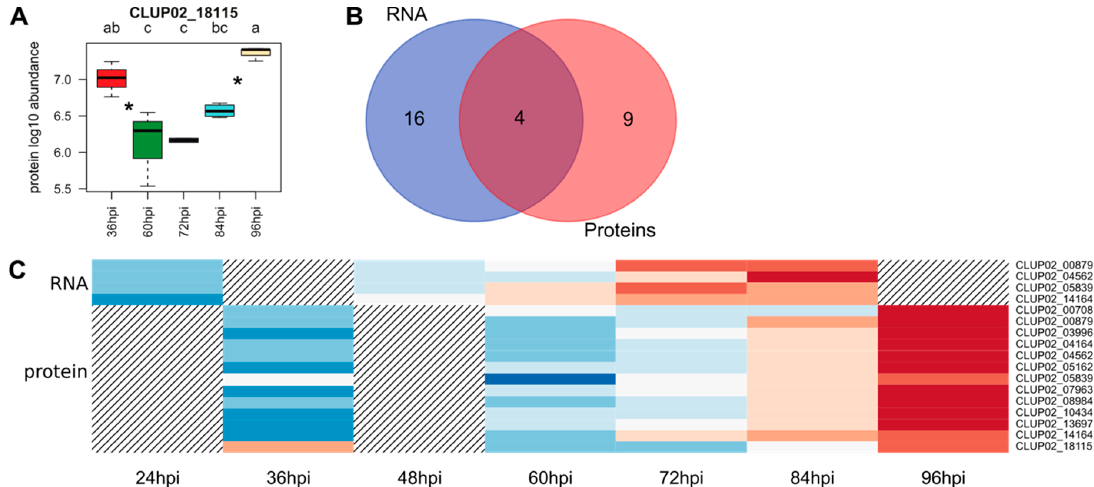
Figure 6. Overview of C. lupini expression and synthesis of candidate peptidases. Boxplot showing the mean abundance of the candidate peptidase from four biological repetitions and quantified by mass spectrometry ( A ). Venn diagram showing the overlap between peptidase-encoding genes upregulated in the RNAseq analysis and the peptidase proteins revealed by proteomic analysis ( B ). Heatmap of the 13 candidate peptidases regarding their abundance and their corresponding transcript expression profile. Hatching areas indicate that data are not available ( C ). Colored bars indicated gene expression by Z-score calculated from normalized reads, and ranging from − 2 (downregulated gene, blue) to 2 (upregulated gene, red), or protein abundance by Z-score calculated from protein log10 abundance, and ranging from − 2 (lowest abundance, blue) to 2 (highest abundance, red). Asterisks between histograms indicate significant changes over time.